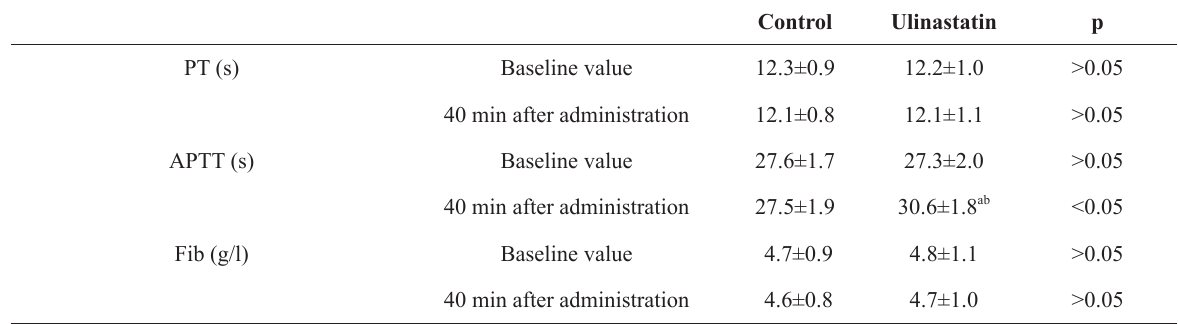
PT, APTT and Fib of patients in two groups (n = 40, x ± s